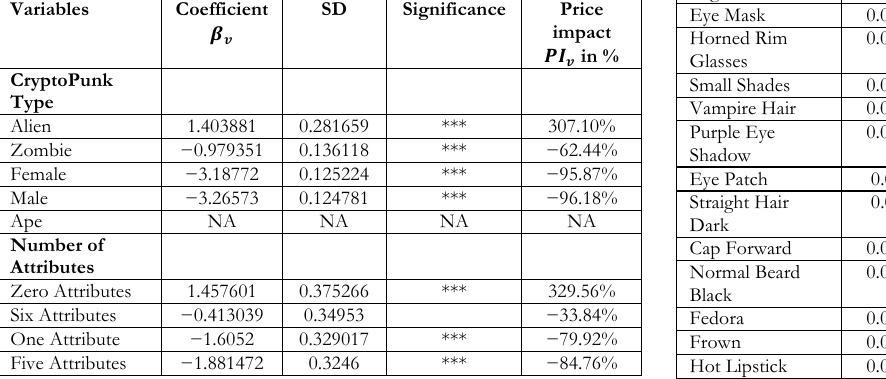
Table 5: Hedonic Variables Regression Results